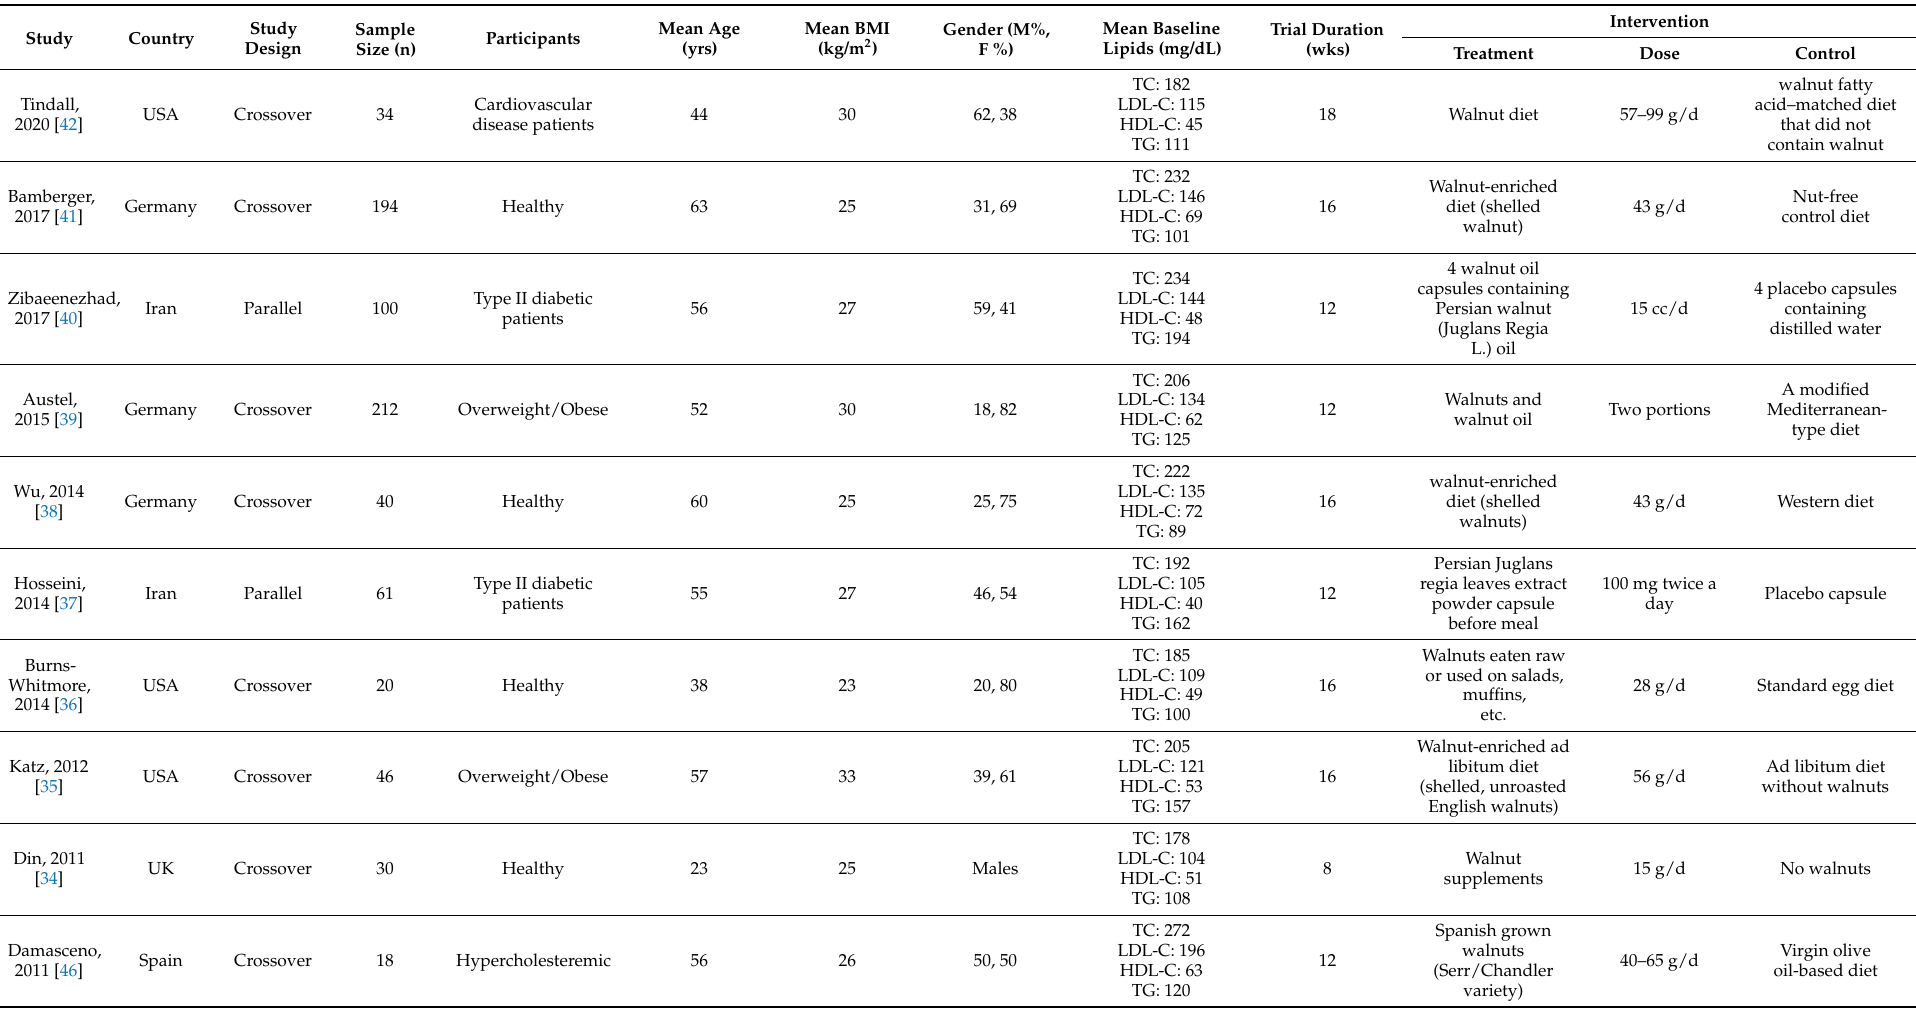
Table 1. Characteristics of included studies in the